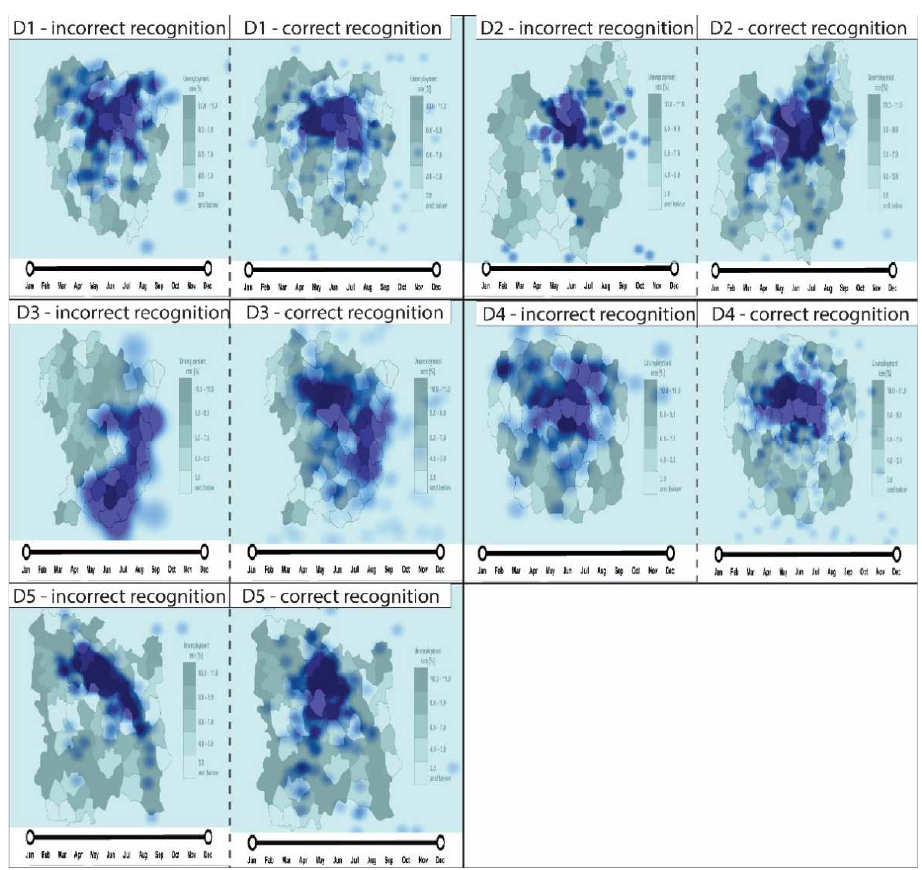
Figure 7. Fixation density clusters for correct and incorrect recognition of spatial patterns and tem- poral trends when analyzing dispersed patterns. temporal trends when analyzing dispersed